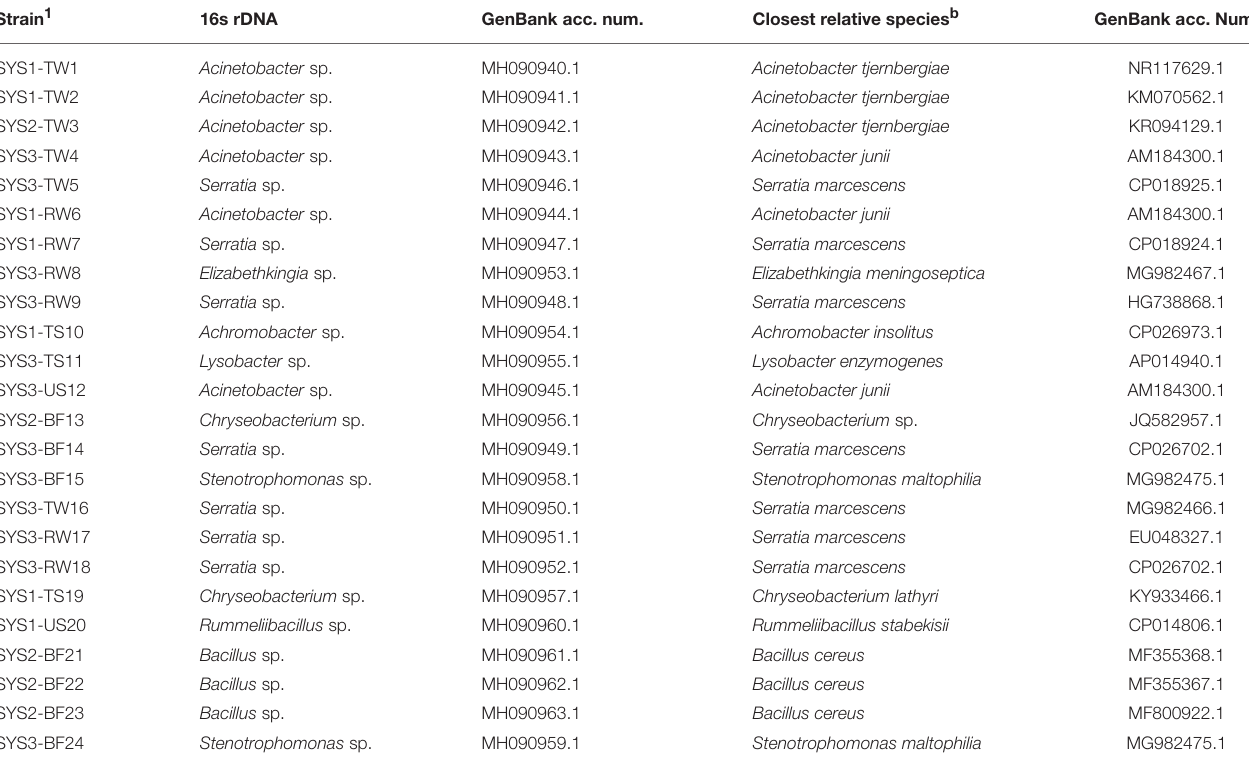
TABLE 2 | Identification of isolated tetracycline-resistant strains by 16SrDNA sequencing. Strain 1 16s rDNA GenBank acc. num. Closest relative species b GenBank acc. Num.